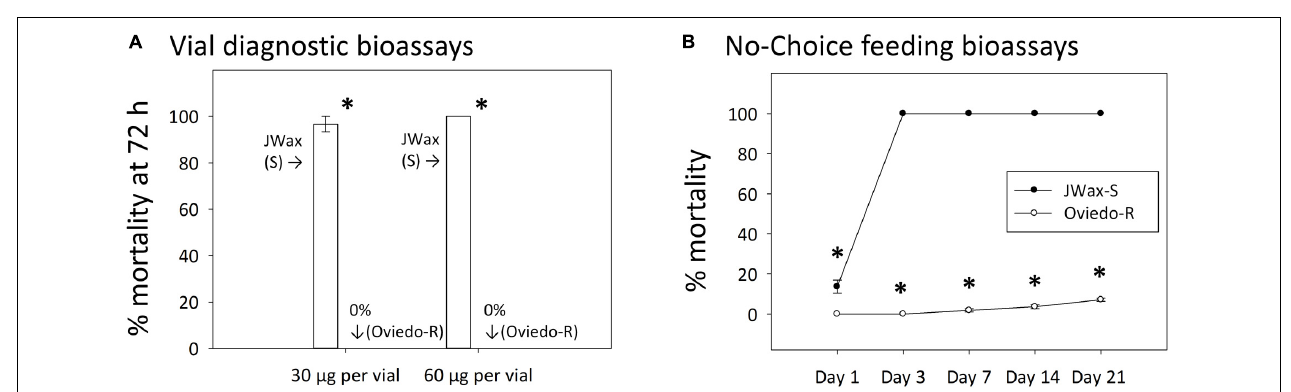
FIGURE 5 | Indoxacarb bioassay results for the highly resistant Oviedo-R strain and the standard susceptible JWax-S strain. (A) Vial diagnostic concentration bioassays at two concentrations showing high-level mortality and the JWax-S strain and 0% mortality in the Oviedo-R strain. (B) No-choice feeding bioassays using commercial formulated indoxacarb bait showing rapid high-level mortality in the JWax-S strain and virtually no mortality in the Oviedo-R strain. ∗ Asterisks indicate significant differences between strains at P <